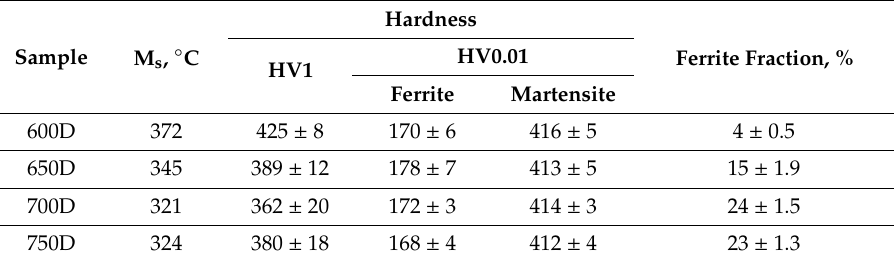
Figure 5. Dilatometric curves of deformed samples: ( a ) cooling from deformation to isothermal Table 4. Experimental results of deformed samples. holding; ( b ) cooling from deformation to isothermal holding—magnification; ( c ) isothermal holding step; ( d ) cooling to room temperature; IH—isothermal holding; RT—room temperature. Table 4. Experimental results of deformed